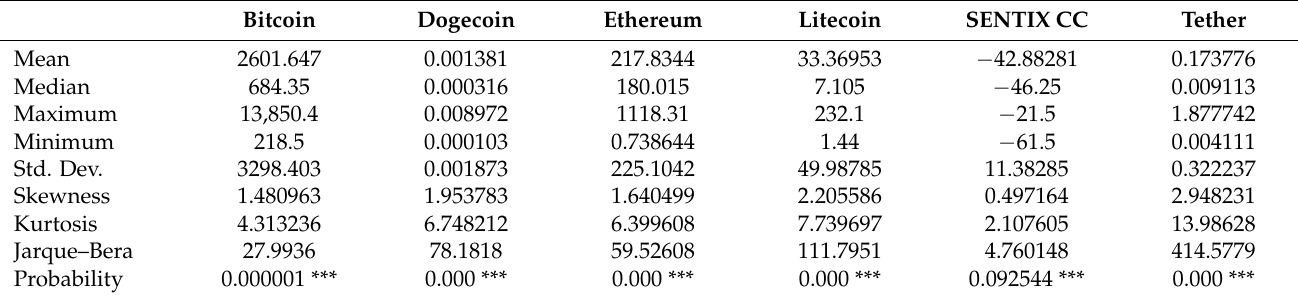
Table 1. Elementary statistics of CC prices and Sentix Investor Confidence index. The sample covers two different sets of monthly data from 15 January 2013 to 15 November 2020. The CC prices are listed on the “Coinmarketcap” site whereas the Sentix CC is provided by